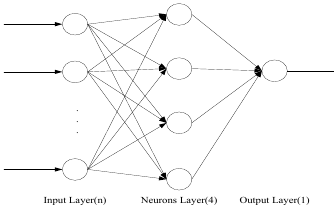
Figure 10. The three-layer neural network